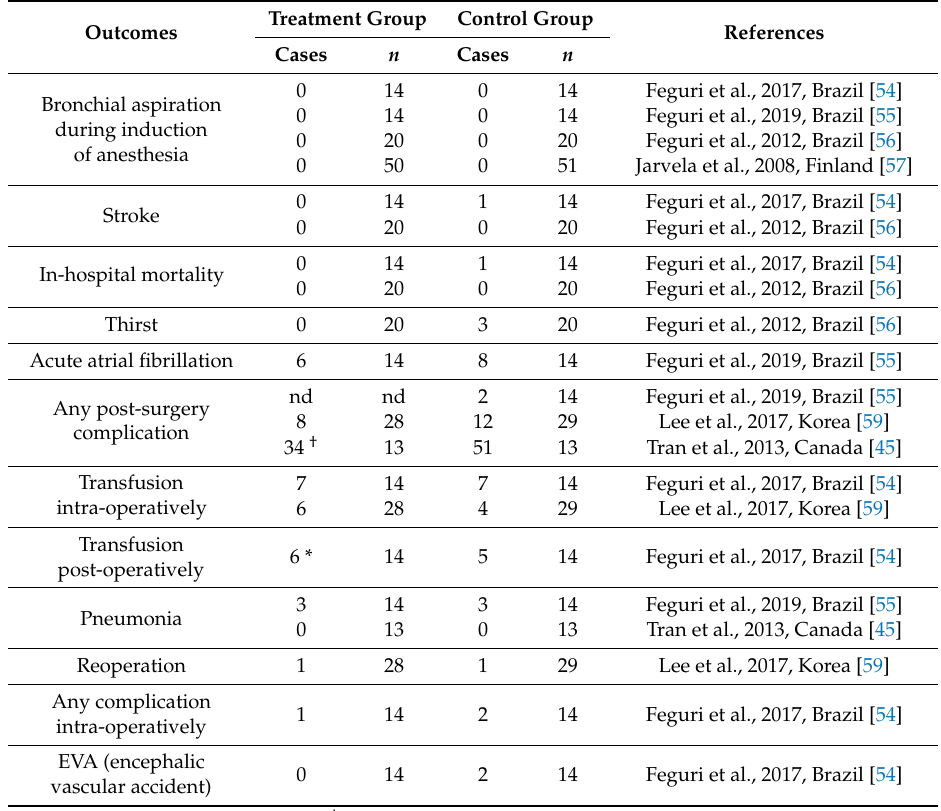
Figure 8. An effect size, risk ratio, for inotropic drugs use in patients taking oral carbohydrates (OCH) drinks vs. controls. Table 2. Qualitative clinical outcomes that were not subjected to meta ‐ analysis. Values are number of patients.